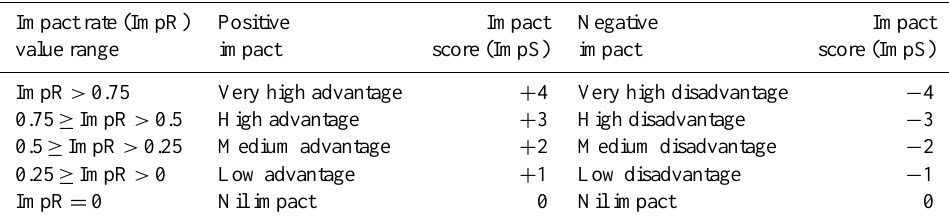
Table 1. A nine-point scale for scoring quantitative impacts. Impact rate (ImpR) Positive Impact Negative Impact value range impact score (ImpS) impact score (ImpS) ImpR > 0.75 Very high advantage + 4 Very high disadvantage − 4 0.75 ≥ ImpR > 0.5 High advantage + 3 High disadvantage − 3 Medium